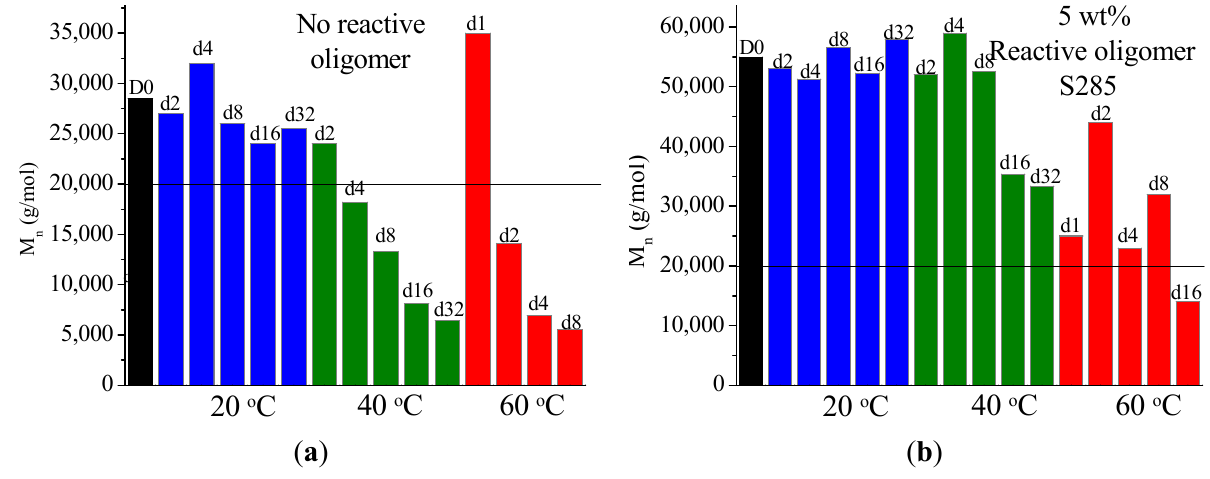
Figure 11. Molecular weight as a function of time and temperature of the ( a ) control blend and ( b ) reactive oligomer